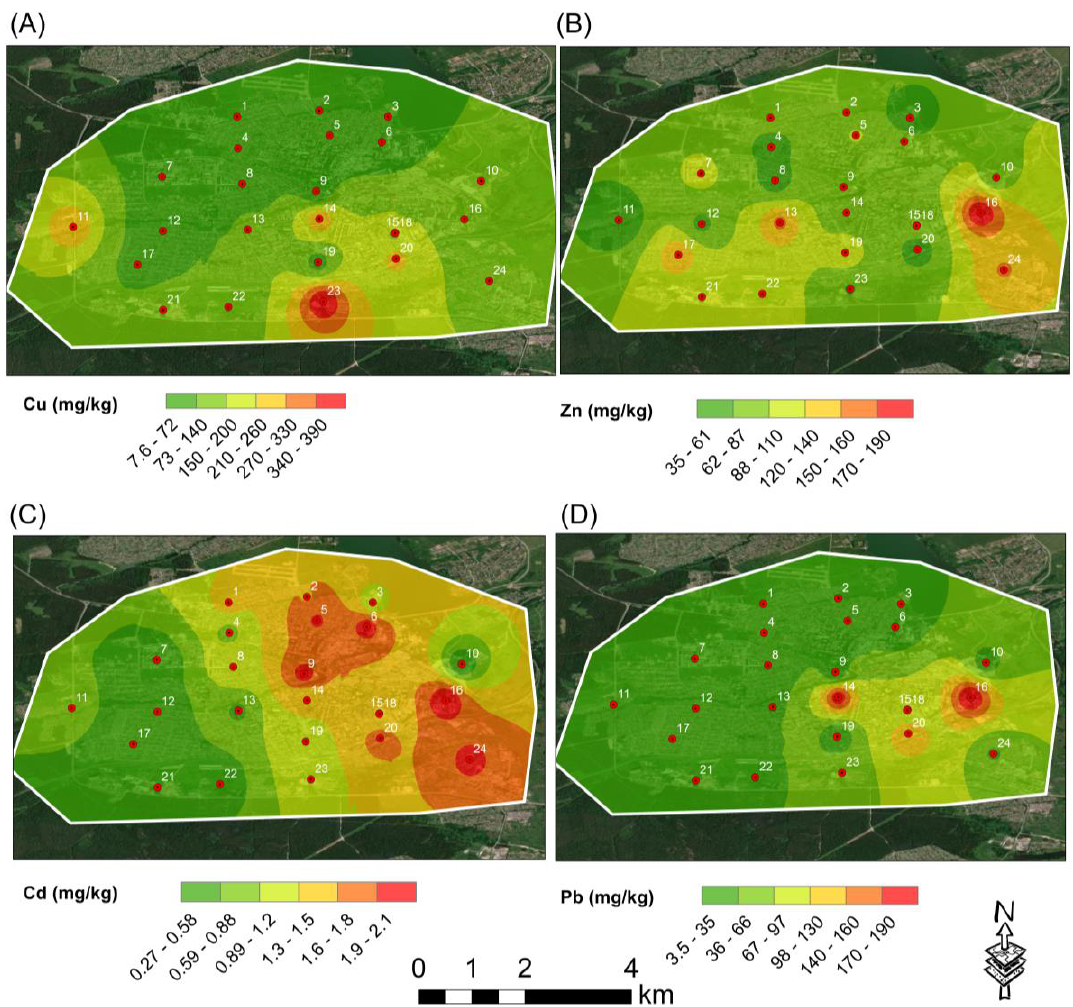
Figure 2. The spatial distribution of the mass fractions (mg/kg) for Cu, Z, Cd, and Pb from ( A – D ), respectively.